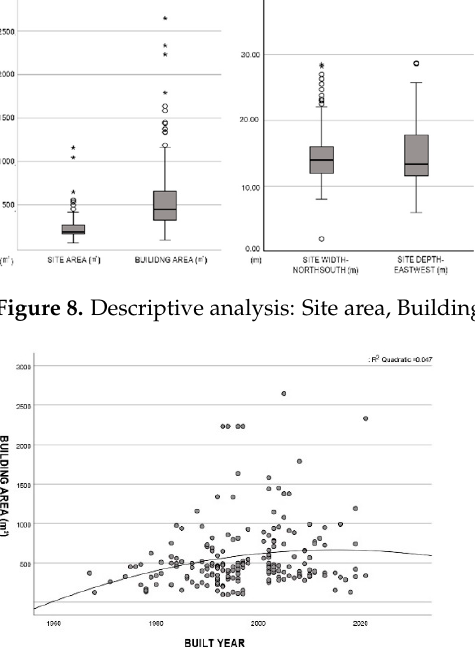
Figure 9. Building areas of per construction years; each dot represents sample buildings.